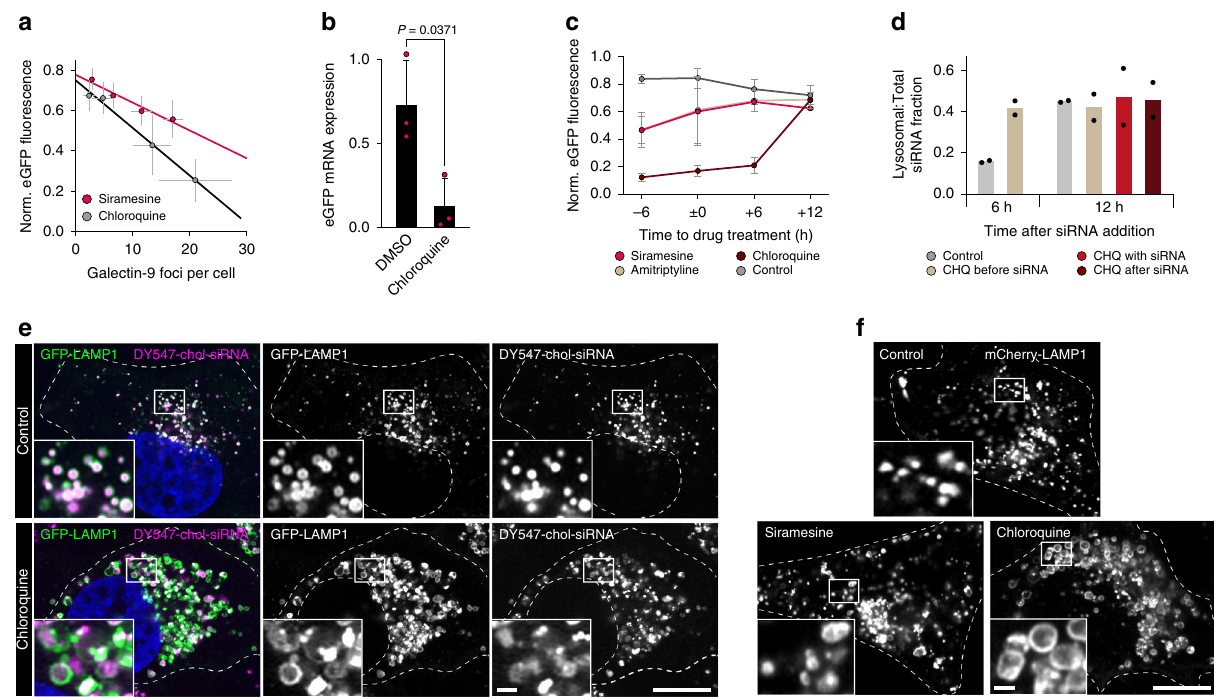
Fig. 3 Knockdown is improved by matching siRNA delivery and small-molecule effects. a Effect on eGFP fl uorescence intensity by increasing number of galectin-9 foci. Mean ± s.d. from Figs. 1d and 2e. N = 3 (galectin-9 foci quanti fi cation), 4 (siramesine eGFP knockdown), 5 (chloroquine eGFP knockdown) independent experiments. Statistical testing was performed by linear regression. b HeLa-d1-eGFP cells were incubated with 40 nM chol-siGFP for 6 h, followed by 60 μ M chloroquine for 18 h. eGFP knockdown was determined by real-time quantitative PCR. Mean± s.d. from three independent experiments. Two-tailed Student ’ s t test. c HeLa-d1-eGFP cells were treated with 60 μ M chloroquine, 60 μ M amitriptyline, or 10 μ M siramesine starting 6 h before, at the same time, or 6 or 12 h after incubation with 40 nM chol-siGFP for 6 h. eGFP knockdown was determined by fl ow cytometry 18 h after starting siRNA incubation. Mean ± s.d. is shown. N = 3 independent experiments. d HeLa cells expressing GFP-LAMP1 were treated with 60 μ M chloroquine (CHQ) starting 6 h before, at the same time or 6 h after incubation with 200 nM DY547-chol-siRNA for 6 h. Cells were fi xed 6 or 12 h after siRNA addition and imaged with an Airyscan confocal microscope. The fraction of chol-siRNA fl uorescence intensity colocalizing with GFP-LAMP1 objects are shown. Bars are mean. N = two independent experiments, each with 10 cells per condition. e , f Airyscan confocal microscopy images of HeLa cells expressing